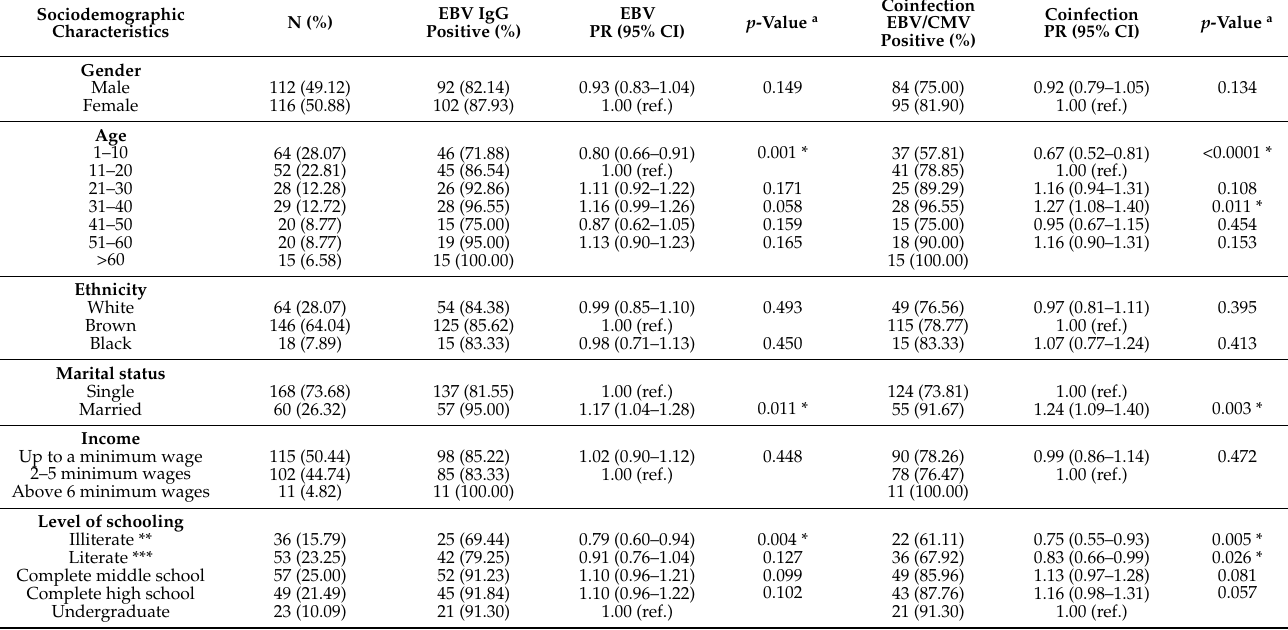
Table 1. Prevalence of EBV infection and EBV/CMV coinfection according to sociodemographic characteristics of the study population. Sociodemographic